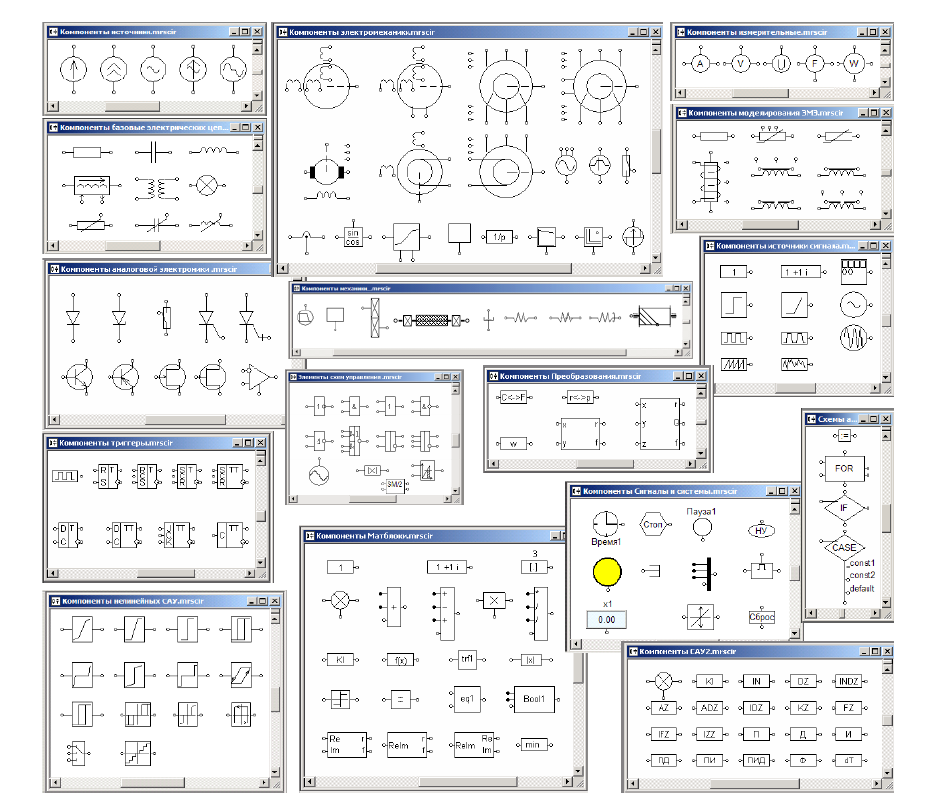
Fig. 3. Key sections of component model library in SE